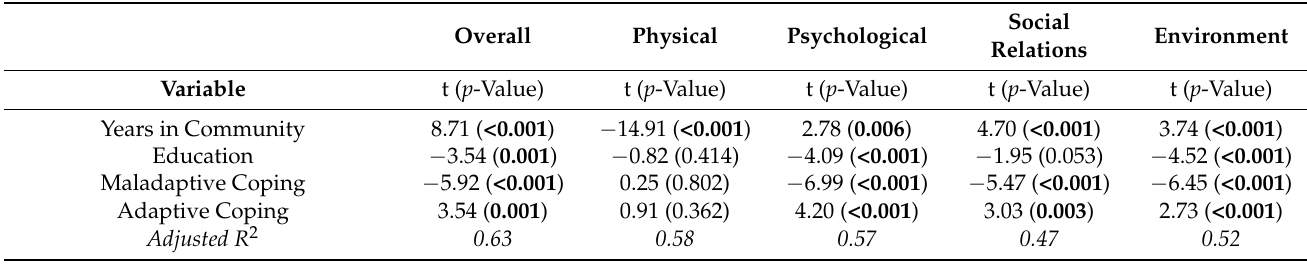
Table 6. Regressions on overall QoL and four QoL subscales for only transgender participants.